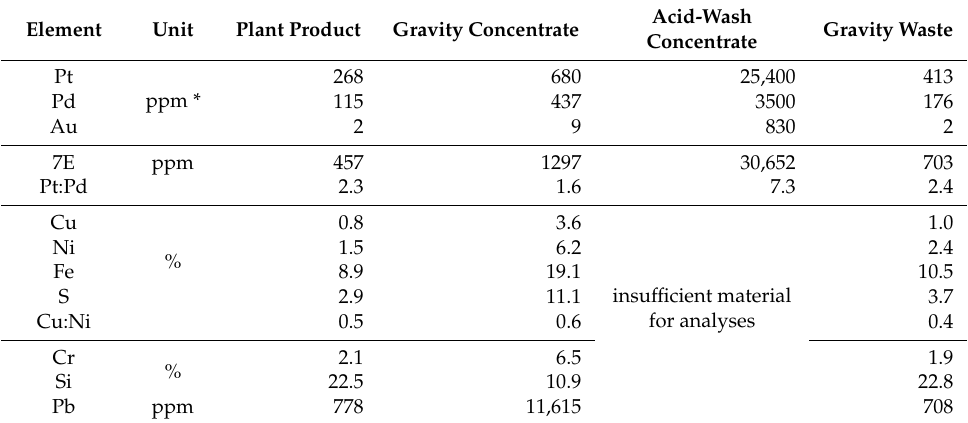
Table 2. Chemical compositions of the UG-2 plant product (low sulphide content).